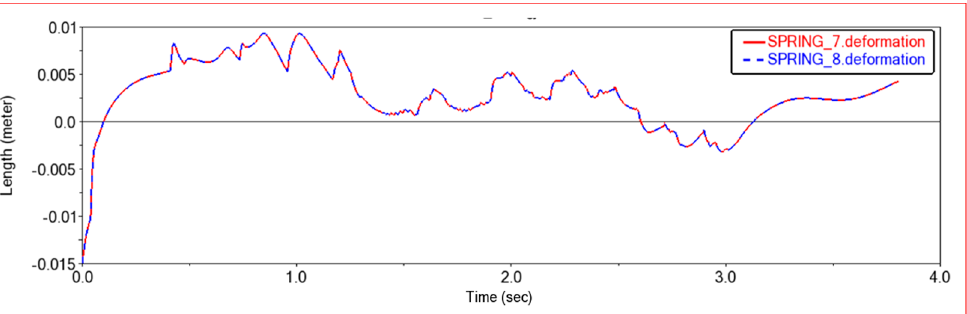
Figure 17. Force diagram of rear frame shock absorber in Experiment 2. SPRING-7-Rear frame left shock absorber; SPRING-8-Rear frame right shock absorber.